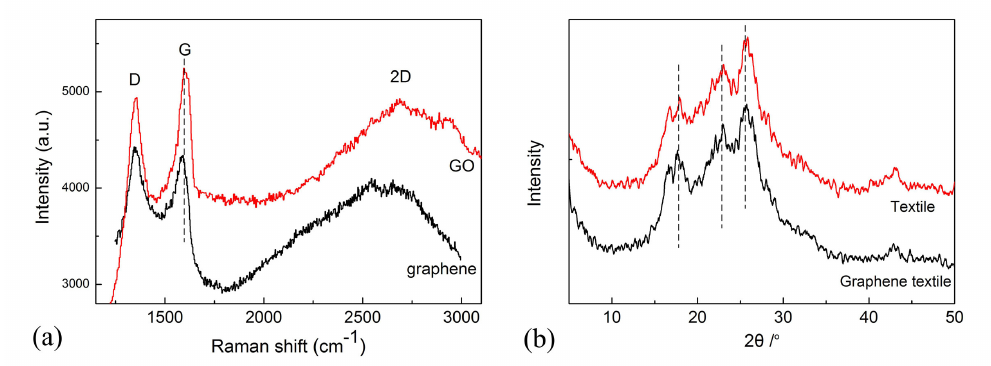
Figure 3. ( a ) Raman spectra of graphene textile before (GO) and after reduction (graphene). ( b ) X-ray diffraction (XRD) curves of polyester textile and graphene